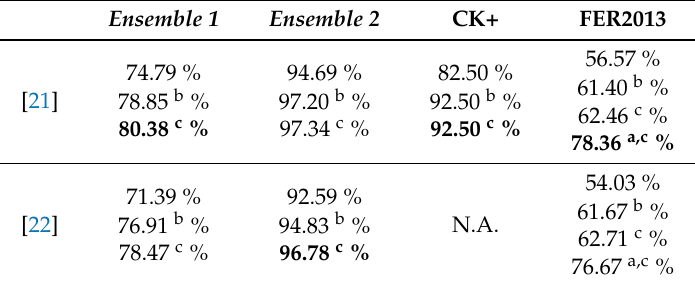
Table 3. Test accuracies summary table (best